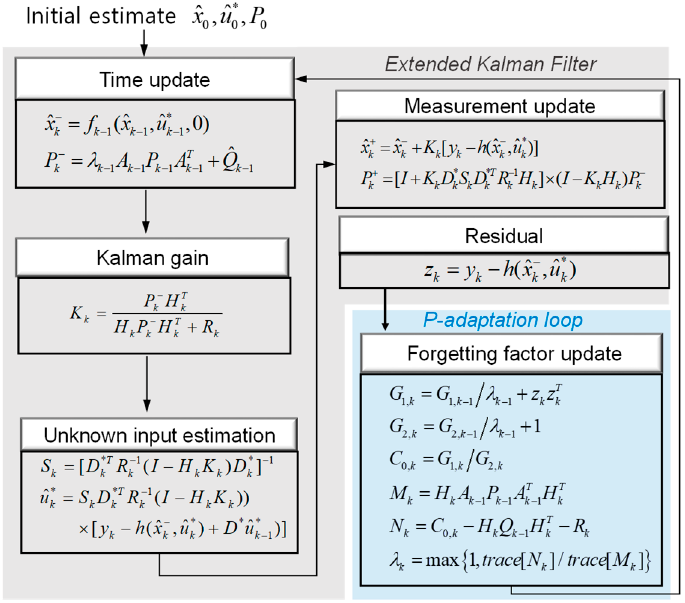
Figure 4. The overall flowchart of AEKF-UI algorithm with P-adaptation loop.